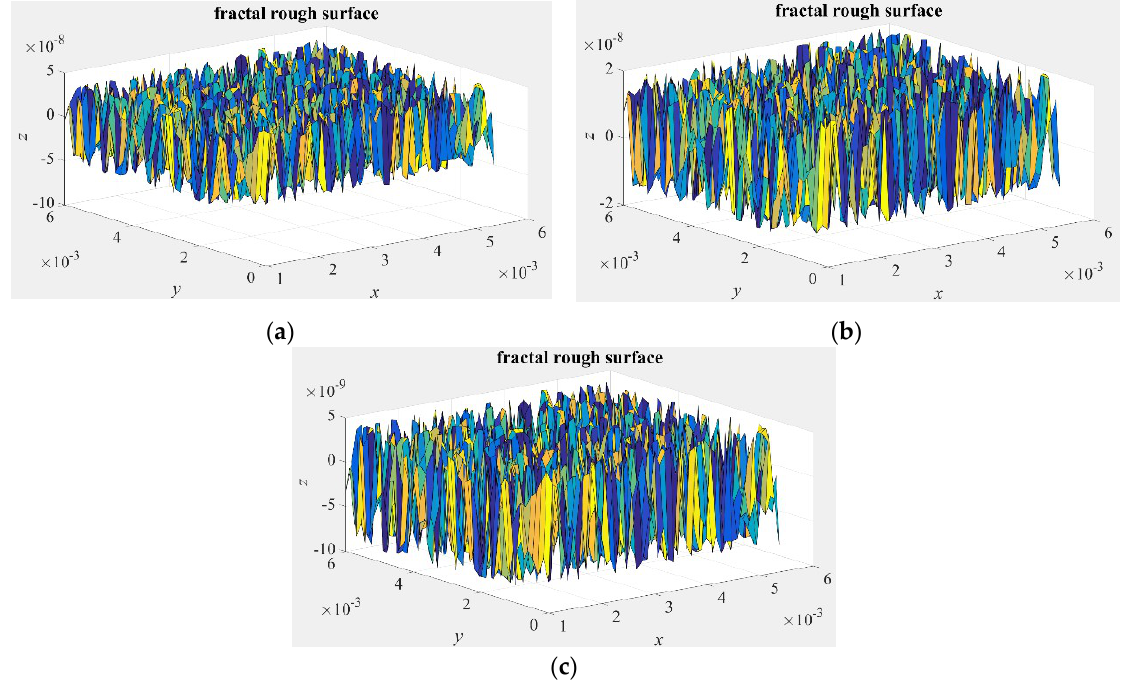
Figure 1. Simulation of a three-dimensional fractal surface topography for different fractal dimensions. ( a ) D f = 2.2, and G = 1 × 10 − 10 m; ( b ) D f = 2.3, and G = 1 × 10 − 10 m; ( c ) D f = 2.4, and G = 1 × 10 − 10 m.